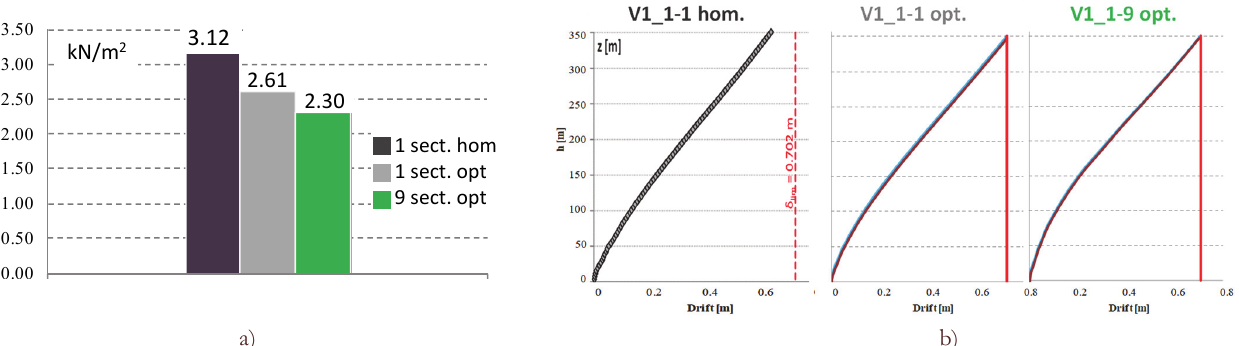
Figure 24: Structural solutions designed for the pattern V1_1: structural weight (a), lateral drifts (b).